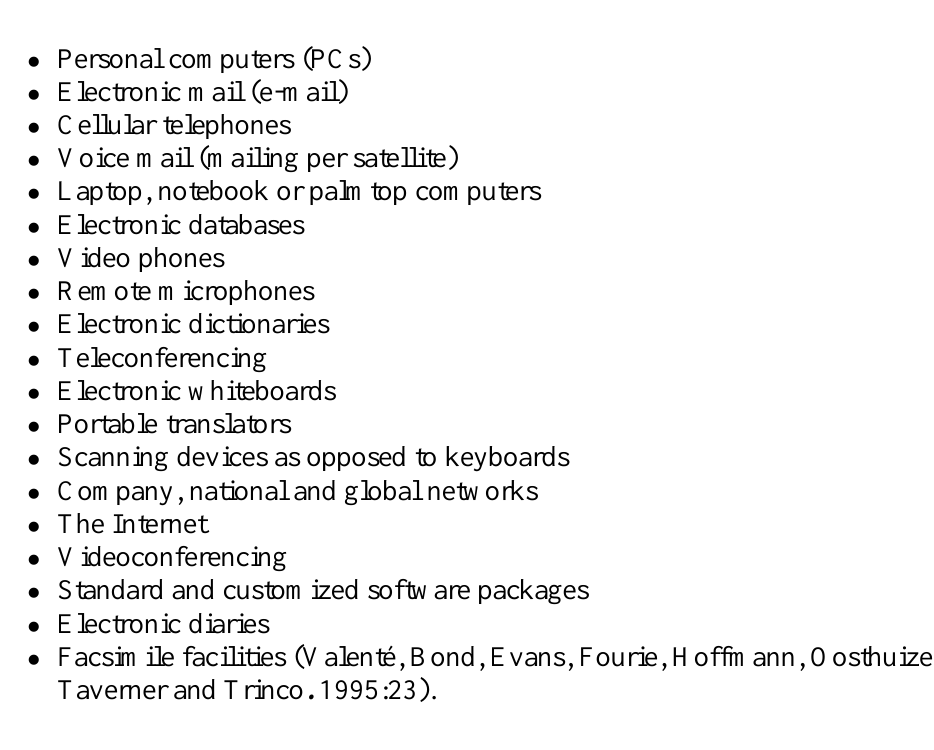
Figure 5 Telework publication Telecommute (picture courtesy of ITAC